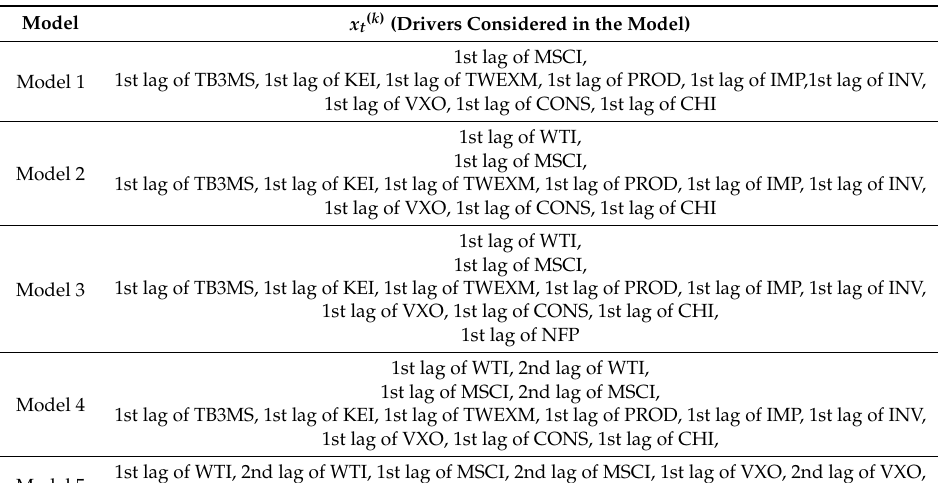
Table 2. Lists of drivers considered in the constructed DMA